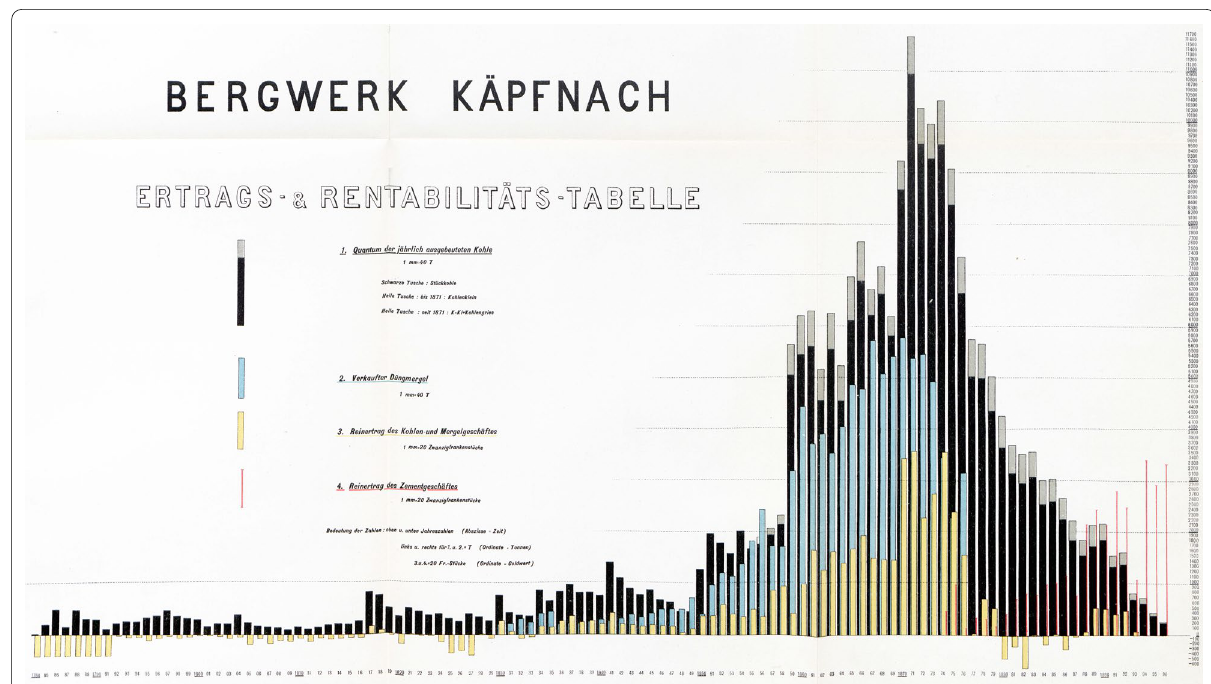
Fig. 9 Outputs and revenues of coal production at the Käpfnach mine during 113 years (reproduced from Letsch, 1899). Vertical axis: tonnages and revenues from 1784–1896. The black bars mark the tonnages of the extracted coal with a maximum of 11 ′ 693 t in 1871 (highest bar). Black : produced coal per year (t), blue : produced fertilising marl (t), yellow : revenues from coal and marl sales (CHF). This coal mine was located near Horgen, situated in the Upper Freshwater Molasse close Lake Zurich, and was first documented in 1548. See Fig. 1 for location of the